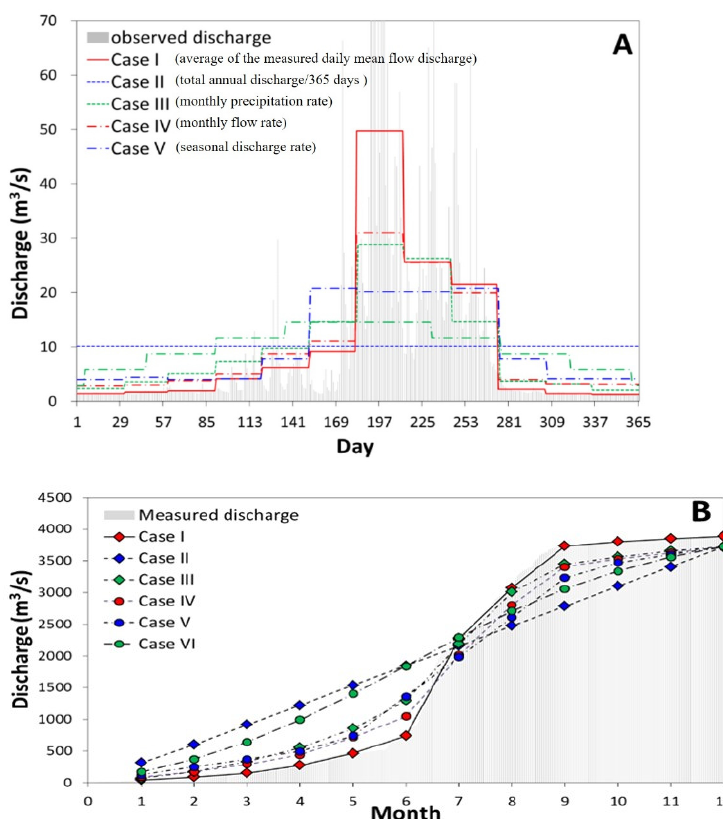
Figure 5. Stream flow generated for each case and the measured during 2013 to 2014 at Byeongseong river: ( A ) daily mean discharge (mean discharge from the daily values), ( B ) discharge mass curve (cumulative discharge volume). Table 3. Generated mean daily discharge for each month with six scenarios.